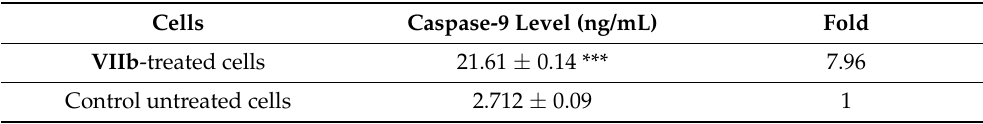
Table 6. Effect of VIIb treatment on caspase-9 level in MCF-7 cell line.